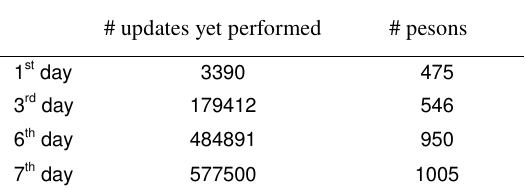
Table 3. Sequences of the long-term experiment